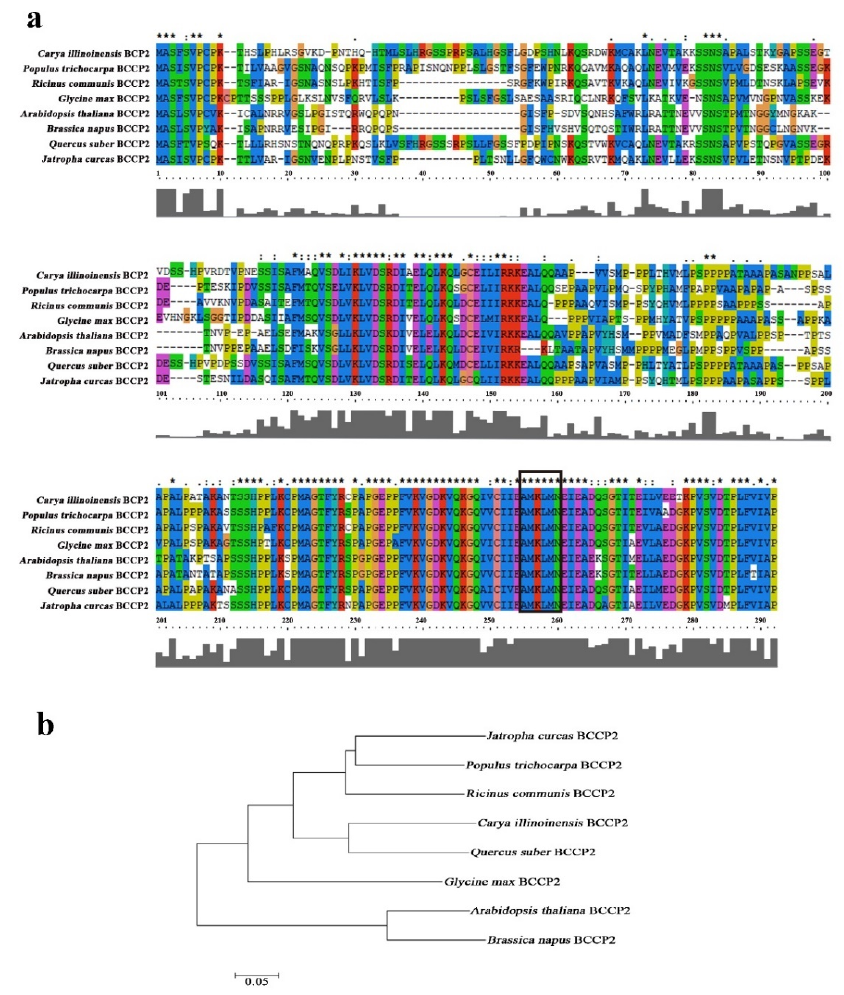
Figure 6. Sequence alignment of CiBCCP2 in different plant species. ( a ) Amino acid sequence alignment of CiBCCP2 and BCCP2-like proteins in indifferent species. ( b ) Phylogenetic analysis of CiBCCP2 and BCCP2-like proteins. Black box indicates the AMKLMN biotinylation domains.